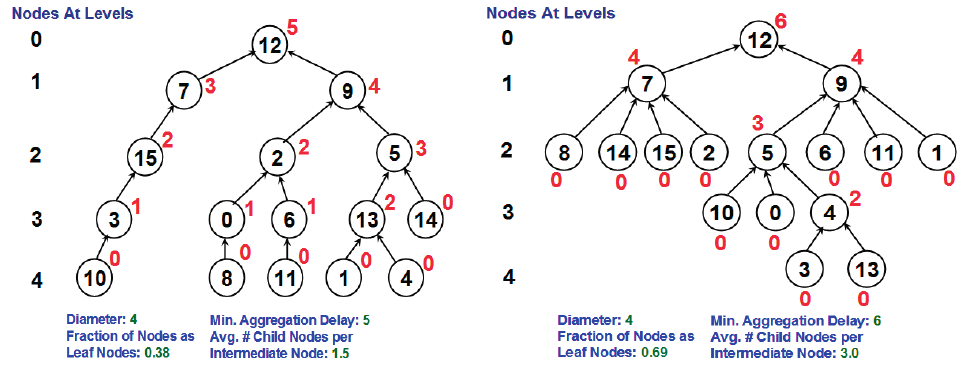
Figure 1. Examples to Determine the Minimum Aggregation Delay for a Data Gathering